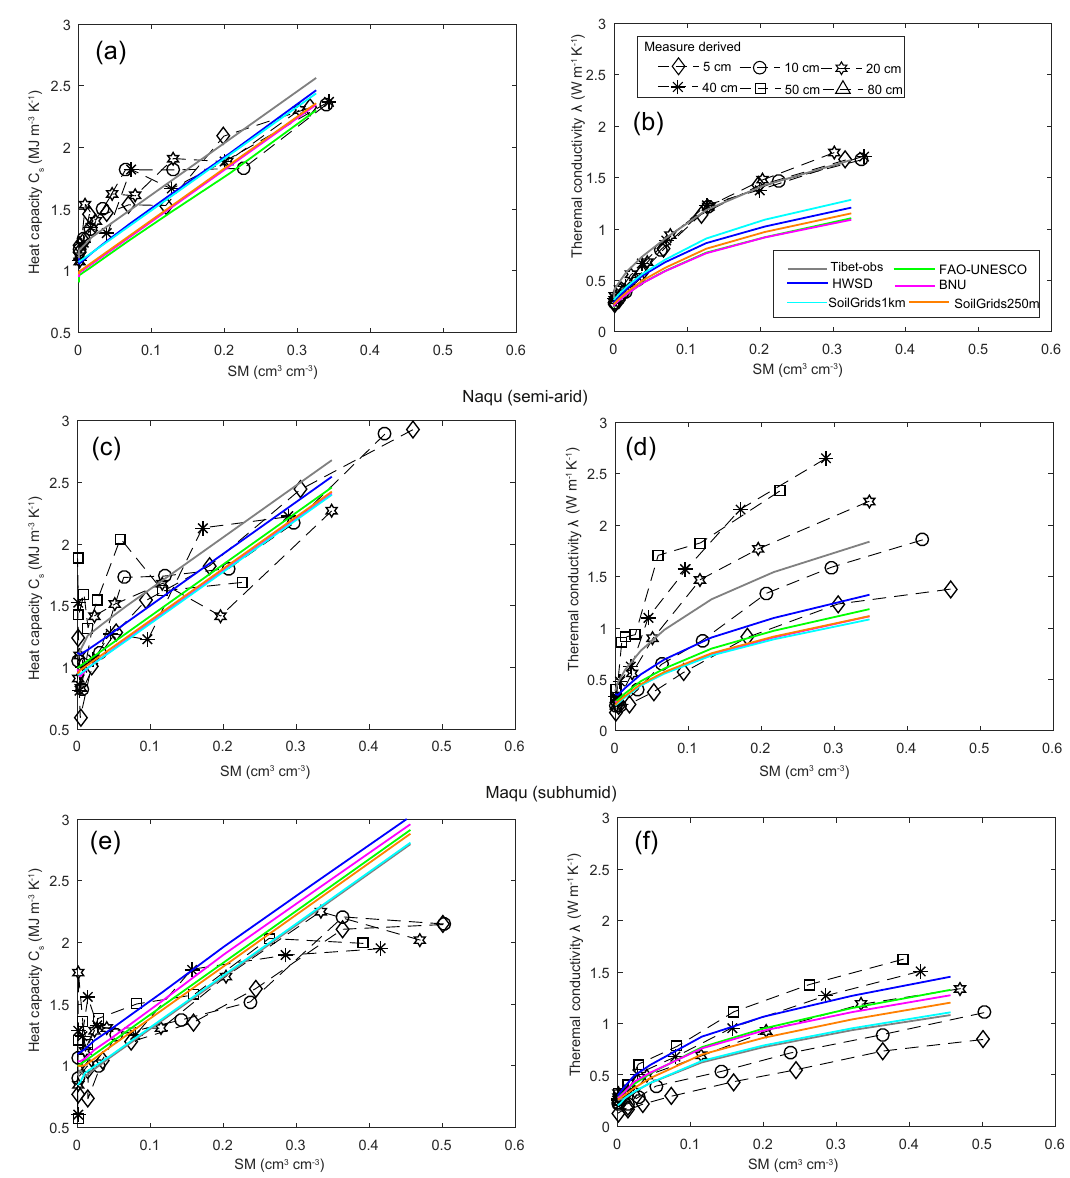
Figure A3. Comparisons of derived C s –SM (a, c, e) and λ –SM (b, d, f) by the D63F model based on various datasets, with the measurements. Given the relatively homogenous soil profile derived from existing datasets (see Fig. 12 in the text), the averaged C s –SM and λ –SM derived from existing datasets over different depths were